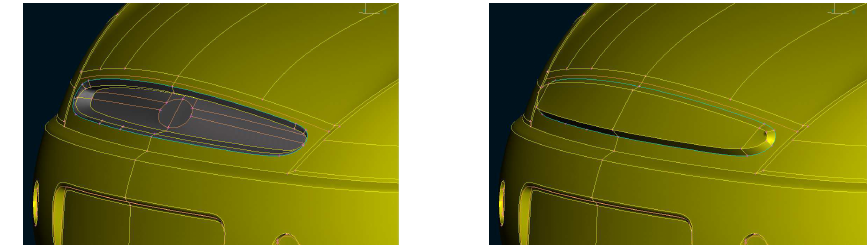
Figure 1: Additional Faces to improve quality of prism elements (right